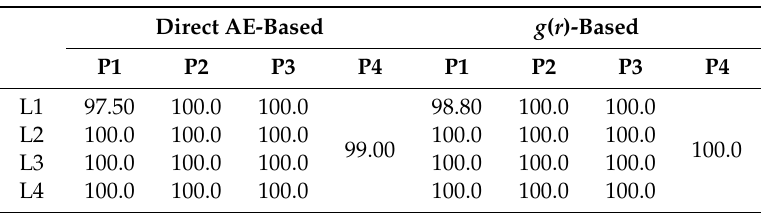
Table 6. Trained classifiers and their accuracy